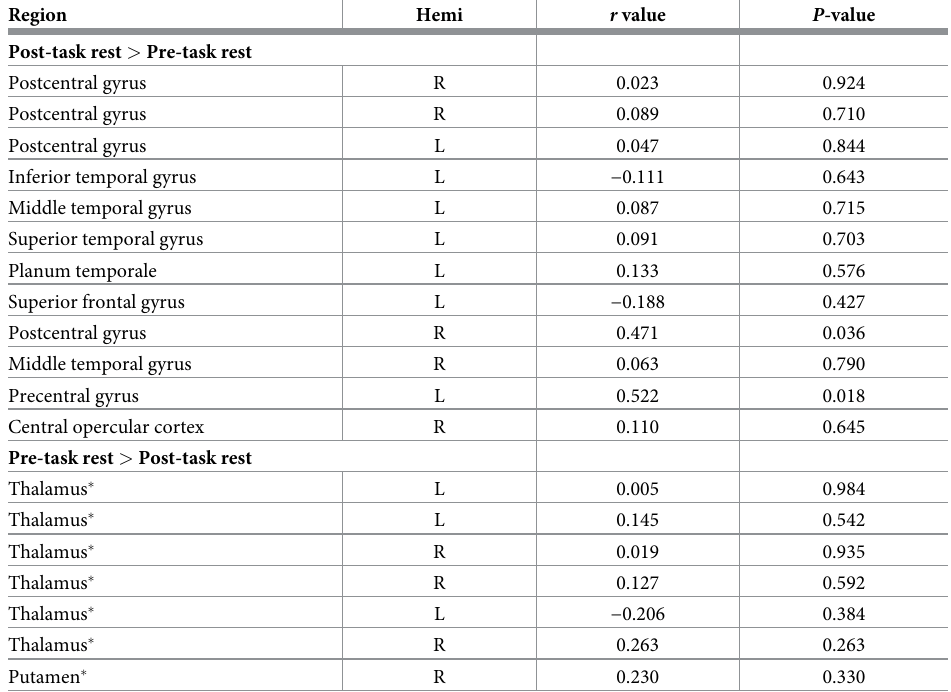
Anatomical labels derived from Harvard-Oxford cortical structural atlas. (cid:3) Labels derived from Harvard-Oxford Subcortical structural atlas. L = left hemisphere, R = right